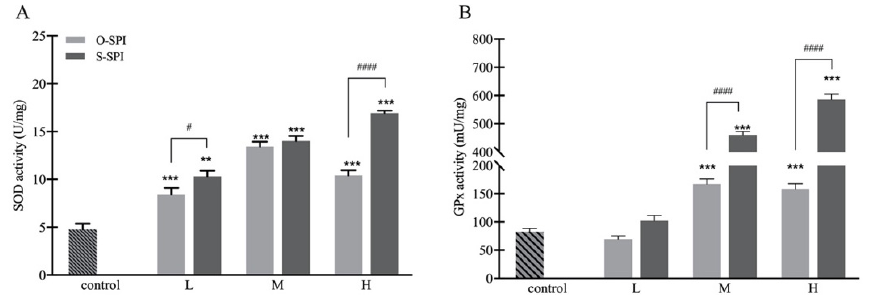
Figure 5. In vivo effects of S-SPI on hepatic antioxidant enzymatic activity of SOD ( A ) and GPx